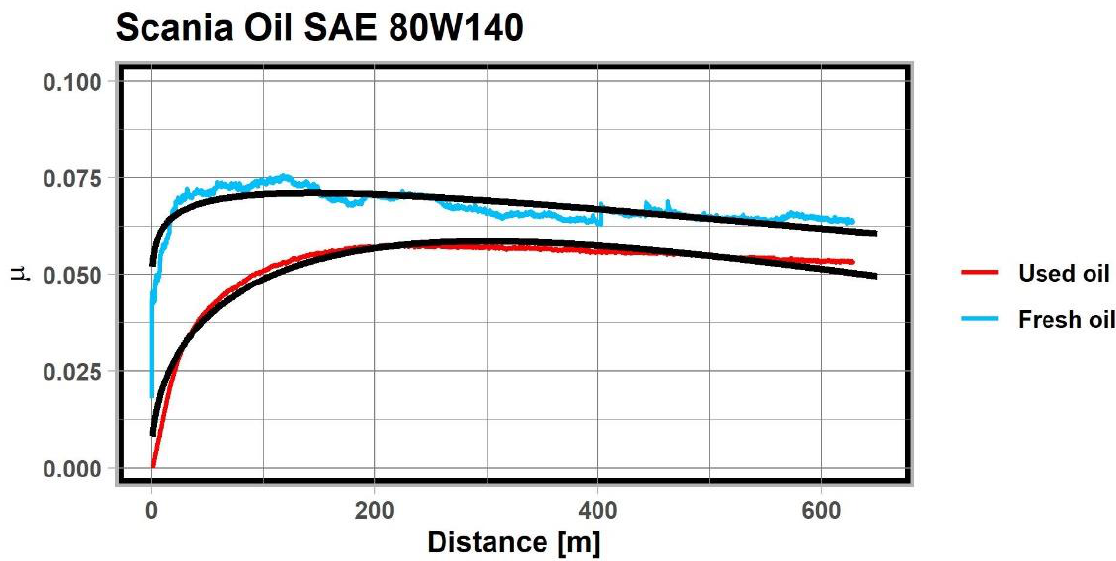
Figure 5. The curve of the friction coefficient depending on the friction path for oil SAE 80W-140 and fitting Function (1).